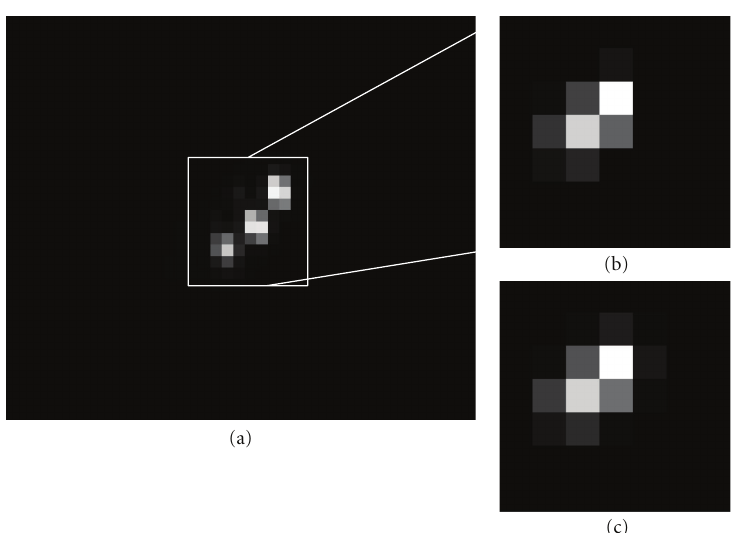
Figure 4: High-resolution images of fluorescently labeled MSCs are used to validate results of model-based processing on working-resolution images. High-resolution (20x) images (a) clearly show three cells. The corresponding low-resolution (7x) image (b) is visually ambiguous. The algorithm gives 3 cells, and the predicated image (c) well fits image data in (b). Note that ≈ 3 × 3 pixels in the high-resolution image correspond to 1 pixel in the low-resolution image and that the “grid” is not exactly maintained. The 2D region in (a) only approximates the region in